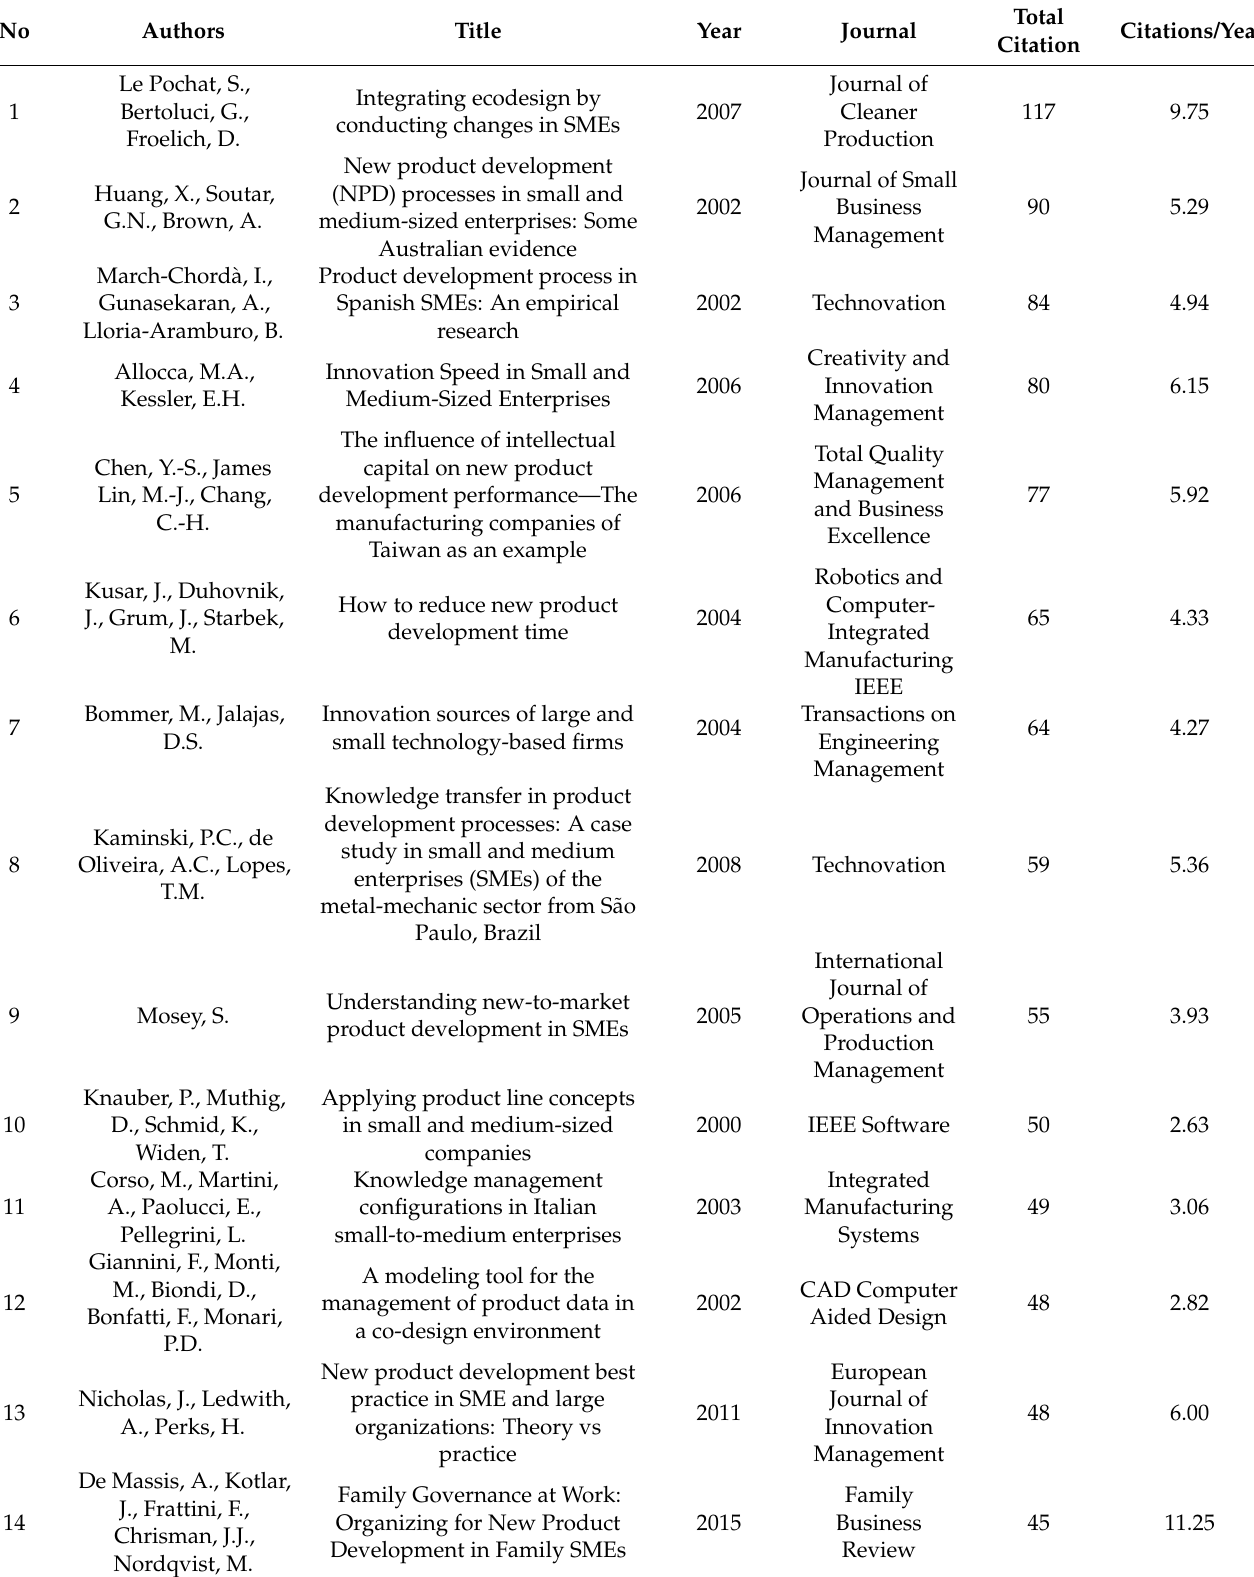
Table 2. Most Cited